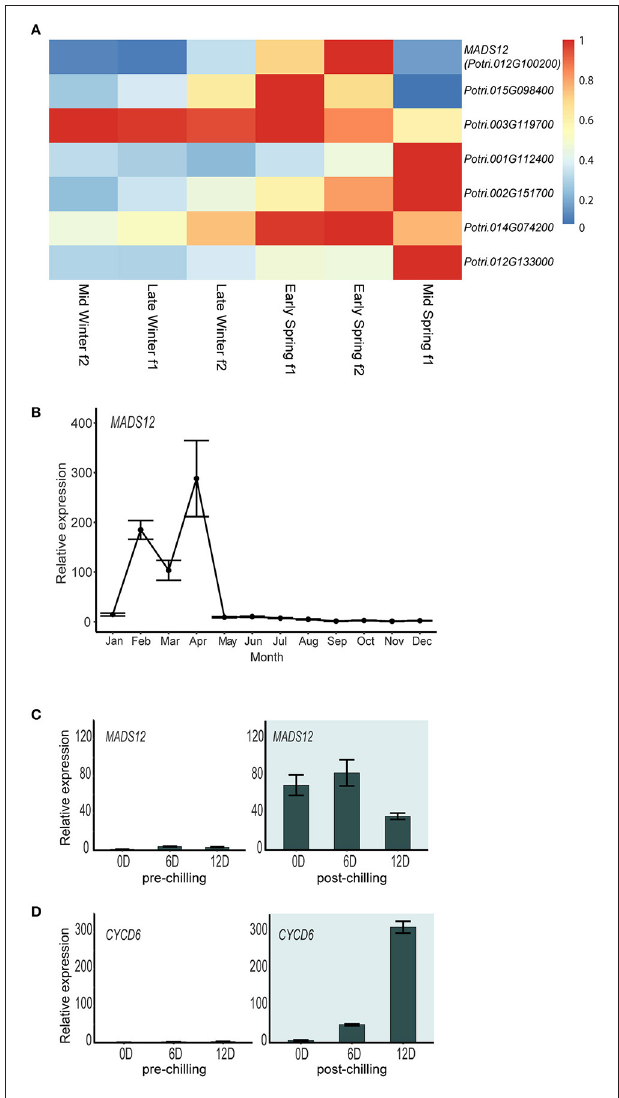
FIGURE 2 | Chilling requirement fulfillment is a prerequisite for MADS12 activation. (A) Heatmap showing normalized expression of hybrid poplar SOC1-like genes from mid-winter to mid-spring in apical buds. Groups are named “early,” “mid,” or “late” when sampling dates were within the first, second, or third month of each season, respectively, following the Northern Meteorological Seasons dates. “f1” or “f2” mean fortnight-1 and fortnight-2 within the month (Conde et al., 2019). (B) MADS12 annual expression pattern measured by qRT-PCR in 2-year-old poplar branches over 1 year. Ubiquitin7 is used as the housekeeping gene. Plotted values and error bars are fold-change means ± s.d. of two biological replicates. Note: MADS12 shows the highest mRNA accumulation during mid-winter–spring period. (C,D) qRT-PCR analysis of MADS12 (C) and CYCD6 (D) genes in dormant shoot apex of pre-chilling and post-chilling cuttings grown under LD and 22 ◦ C conditions. Ubiquitin7 is used as the housekeeping gene. Plotted values and error bars are fold-change means ± s.d. of two biological replicates. The x-axis scale is indicated in days. Pre-chilling and post-chilling data are shown in white and green backgrounds,